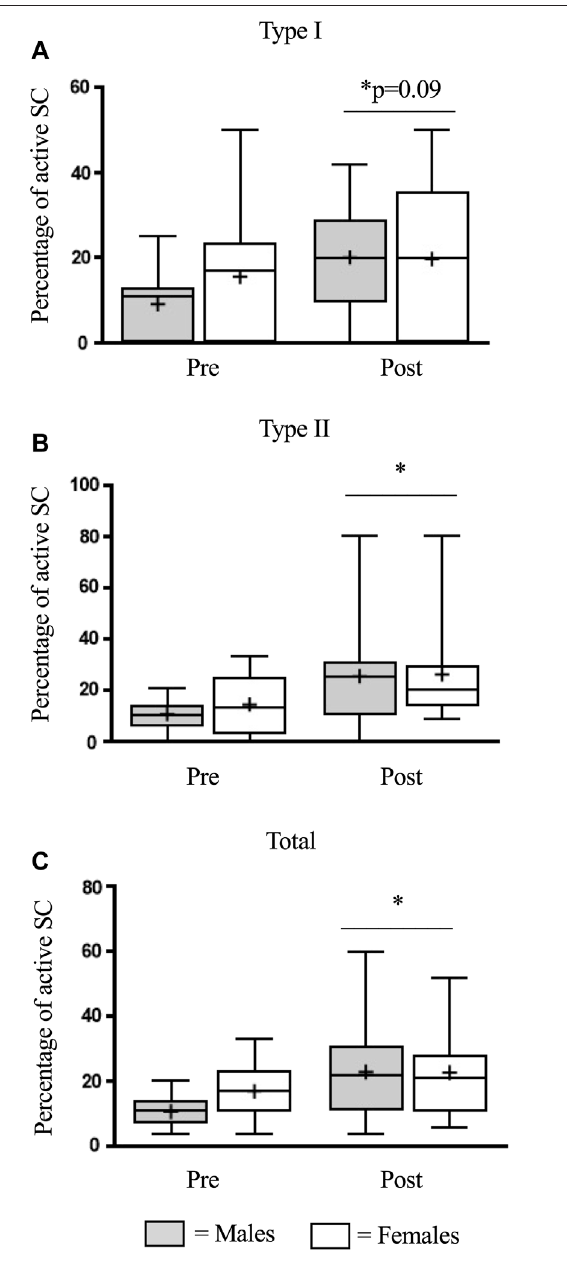
FIGURE 4 | The percentage of activated satellite cells (SC) in type I (A) , type II (B) , and total (C) muscle fi bres before (pre) and 48 h (post) following eccentric damage. The box-and-whisker plot displays the median (line) and the mean (+), with the box representing the interquartile range (IQR), and the whiskers representing the maximum and minimum values. * indicates a signi fi cant effect of time ( p <